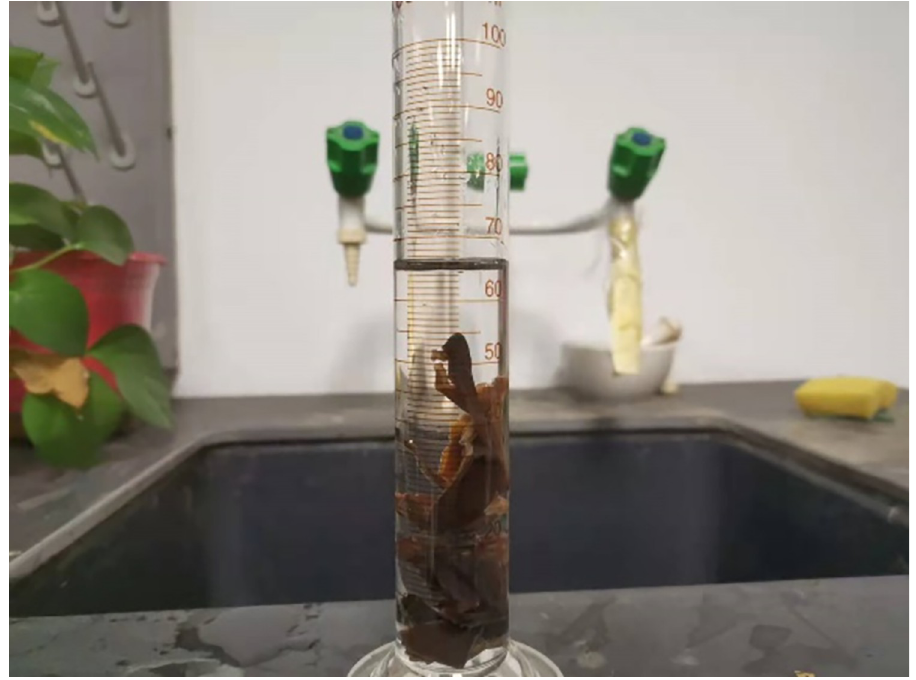
Fig 9. Density test of black